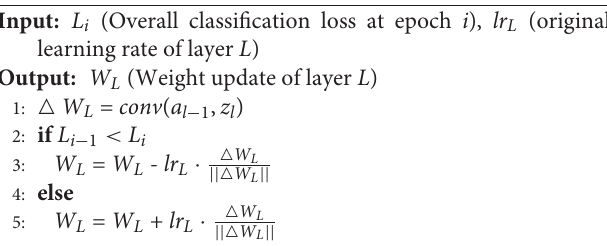
Algorithm 2 Weak Supervision